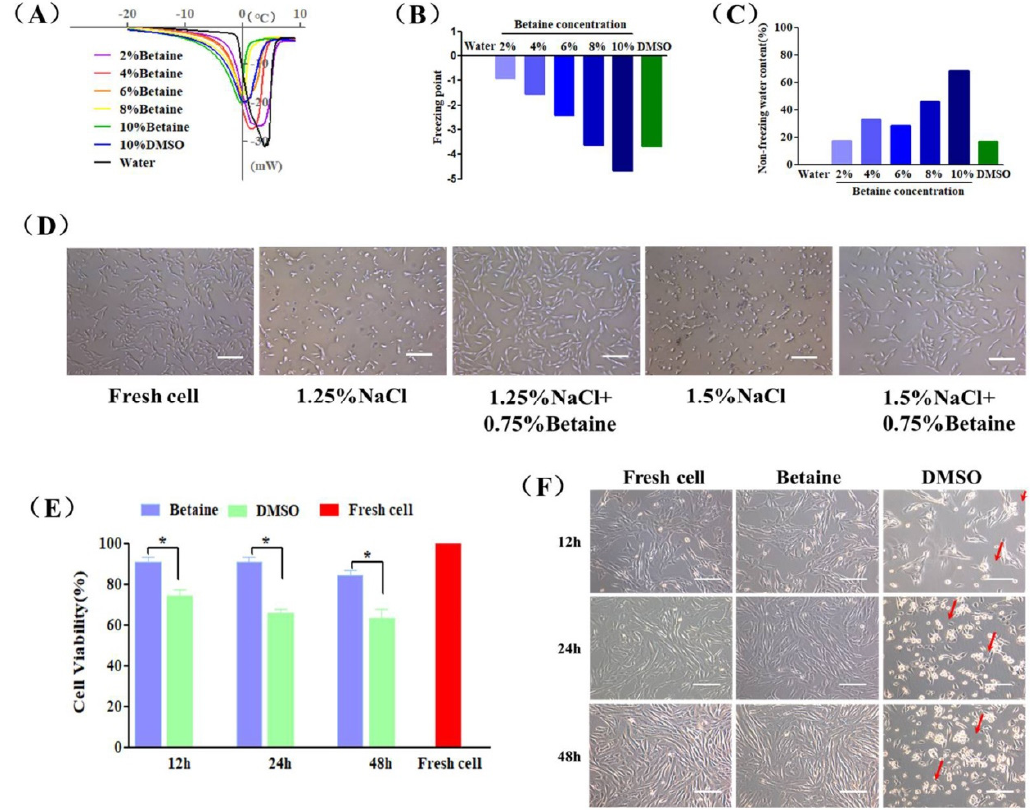
Figure 1. Cryoprotective properties and cytotoxicity of betaine. ( A ) DSC melting thermograms, ( B ) freezing point and ( C ) non-freezing water content of pure water (Water), betaine solutions (2–10%, w / v ) and DMSO solution (10%, v / v ). ( D ) The morphology of UCMSCs exposed in culture medium containing 1.25% NaCl ( w / v ), 1.25% NaCl ( w / v ) + 0.75% betaine ( w / v ), 1.5% NaCl ( w / v ), 1.5% NaCl ( w / v ) + 0.75% betaine ( w / v ) for 24 h, and culture medium (Fresh cell) as a control. ( E ) Cell survival rate and ( F ) microscopic images of UCMSCs incubated with culture medium (Fresh cell), 2% betaine (Betaine) or 2% DMSO (DMSO) for 12, 24, and 48 h. The red arrows mark deformed or floating UCMSCs. Scale bar = 200 µ m. Value = mean ± standard deviation, n = 3. * p <